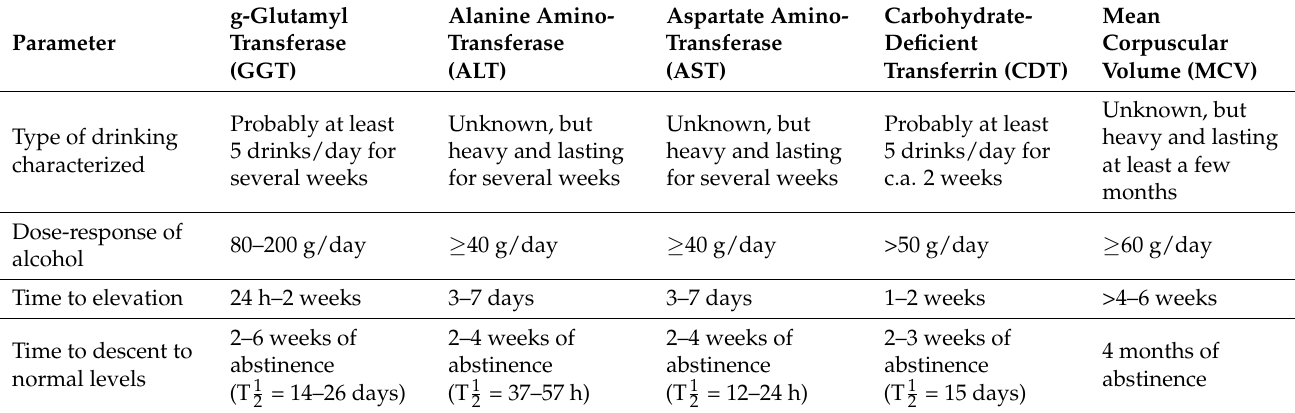
Table 1. Summary characteristics of traditional alcohol